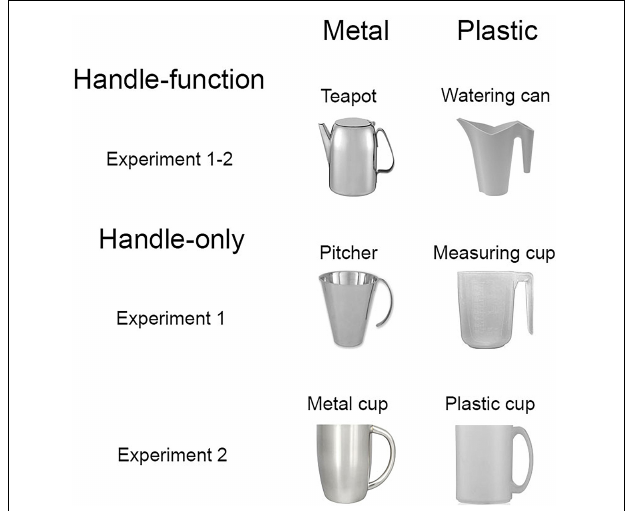
FIGURE 1 | Handle-function (i.e., upper panel), and handle-only (middle and lower panel) objects made of metal (leftmost panel) and plastic (rightmost panel) used in the two experiments. All objects are depicted with the handle on the right. Elements are not drawn to scale.